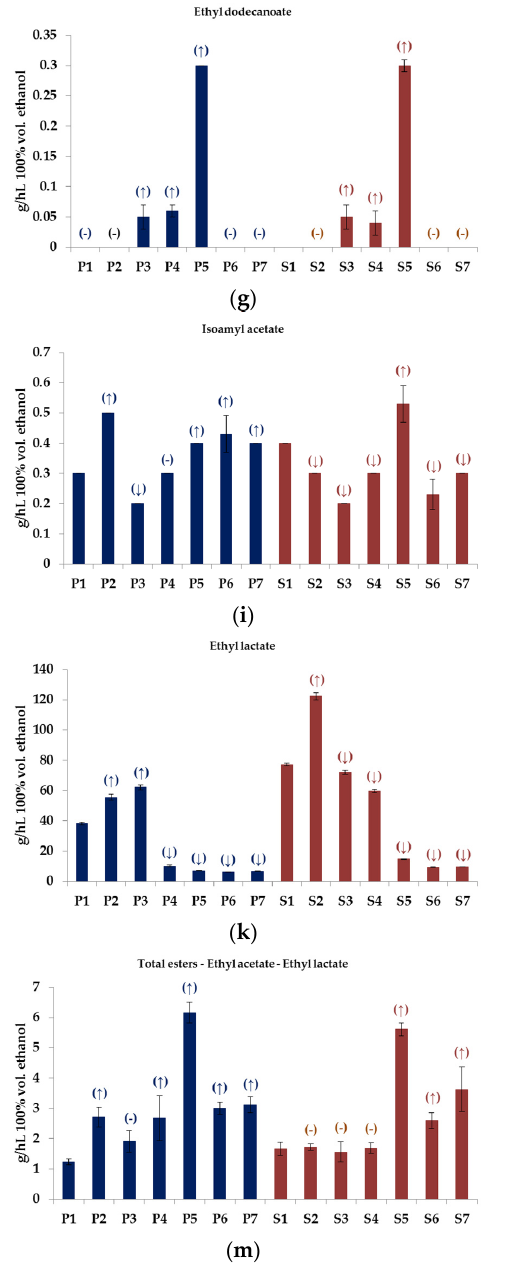
Figure 2. Content of esters (g/hL 100% vol. ethanol) in plum spirits of Požegaˇca (P) and Stanley (S) varieties produced by traditional method (P1 and S1) and modified methods (P2–P7 and S2–S7): ( a ) TE, ( b ) E1, ( c ) E2, ( d ) E3, ( e ) E4, ( f ) E5, ( g ) E6, ( h ) E7, ( i ) E8, ( j ) E9, ( k ) E10, ( l ) TE-E1, and ( m ) TE-E1-E10. (Codes are listed in Table S1 of Supplementary Materials.) For each plum variety, different marks indicate differences in the means ( p < 0.05), according to Dunnett test: ( ↑ ) Statistically significant higher values compared to values in traditionally produced plum spirit, ( ↓ ): Statistically significant lower values compared to values in traditionally produced plum spirit, (-): No statistically significant differences in values compared to values in traditionally produced plum spirit. Concentrations of all parameters are shown as mean ± standard